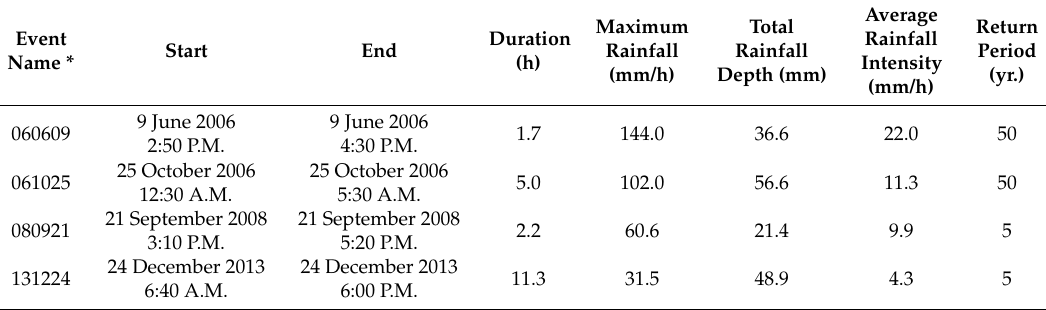
Table 2. Summary of rainfall records in Zona Central case study.